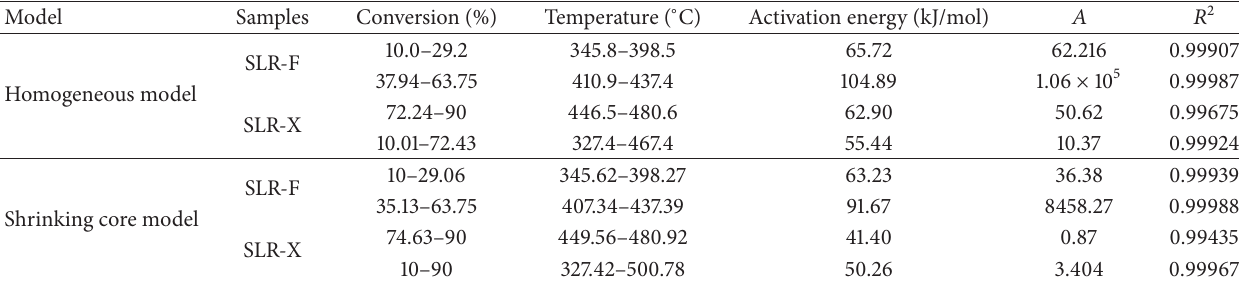
Table 5: Kinetic parameters of